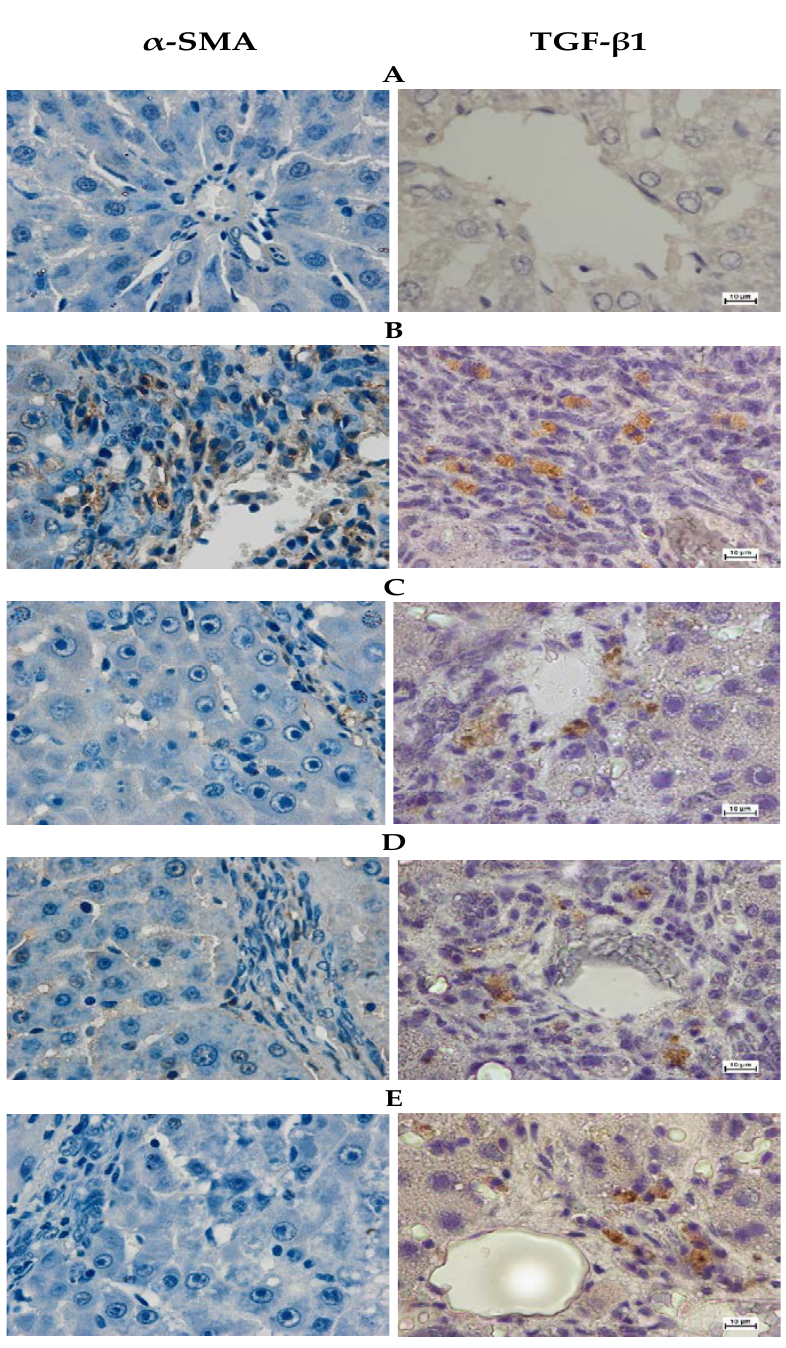
Figure 4. Immunohistochemistry: Effects of A. muricata extract on α -SMA staining in the liver. ( A ) Normal control group, no α -SMA expression (down-regulation); ( B ) rats treated with thioacetamide (hepatotoxic group), α -SMA expression of hepatocytes (up-regulation); ( C ) rats treated with thioacetamide + silymarin, mild α -SMA expression (down-regulation); ( D ) rats treated with thioacetamide + 250 mg/kg A. muricata , mild α -SMA expression (down-regulation), and ( E ) rats treated with thioacetamide + 500 mg/kg A. muricata , (down- regulation) (α -SMA stain, magnification 40x). TGF- β1 staining : ( A ) Normal control group, no TGF- β1 expression (down -regulation); ( B ) TAA-treated group, TGF- β1 expression of hepatocytes was seen (up-regulation); ( C ) TAA + Silymarin group, mild TGF- β1 expression (down -regulation), ( D ) TAA + 250 mg/kg A. muricata , mild TGF- β1 expression (down-regulation); ( E ) TAA + 500 mg/kg A. muricata , mild TGF- β1 expression (down-regulation) (TGF- β1 stain, magnification 40x).